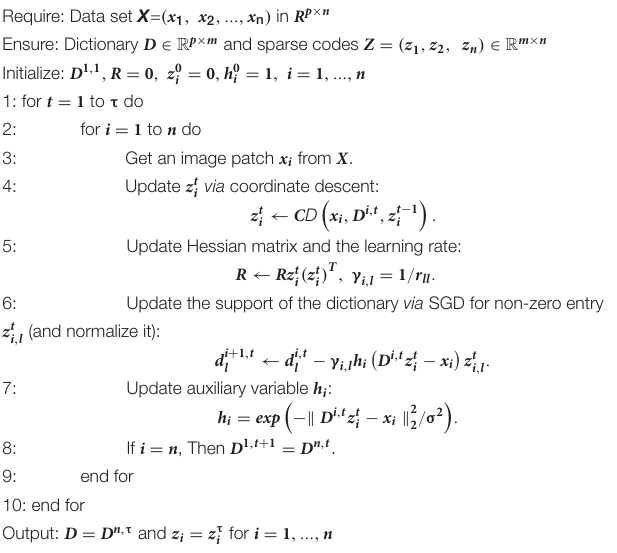
Algorithm 1: Patch analysis-based surface correntropy-induced